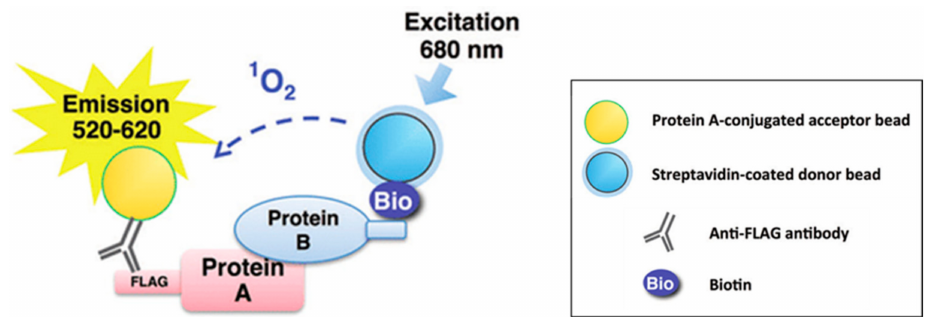
Figure 6. Amplified luminescent proximity homogeneous assay screen (AlphaScreen) Method. AlphaScreen allows screening for a broad range of targets. The technology provides an easy and reliable means for determining the interaction of proteins and also the effect of compounds on biomolecular interactions. AlphaScreen assay is adaptable for measuring protein activities and proteins harboring post-translational